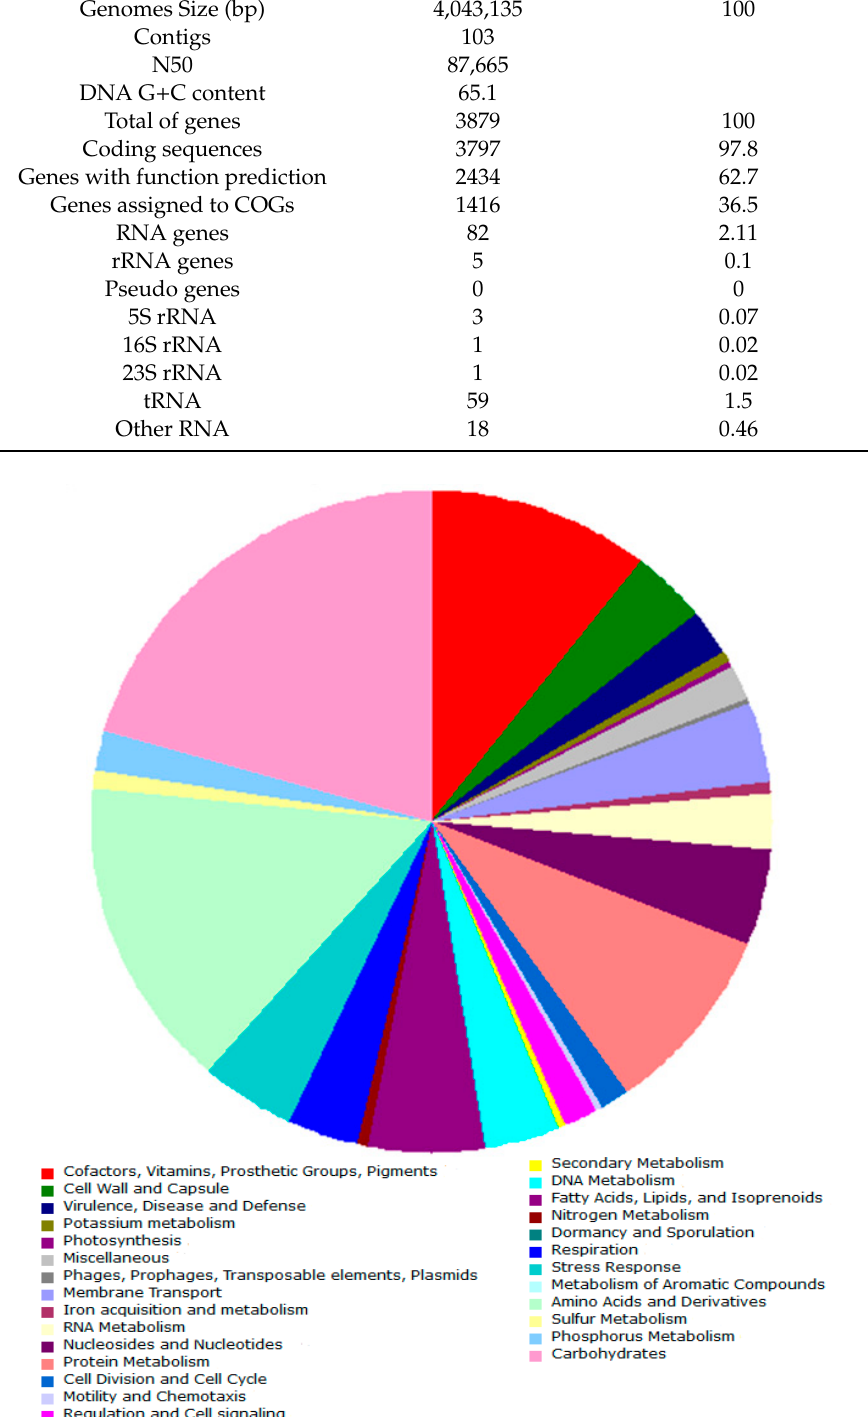
Figure 3. Metabolic subsystems of S. vilae DB165 T annotated through the RAST webserver.